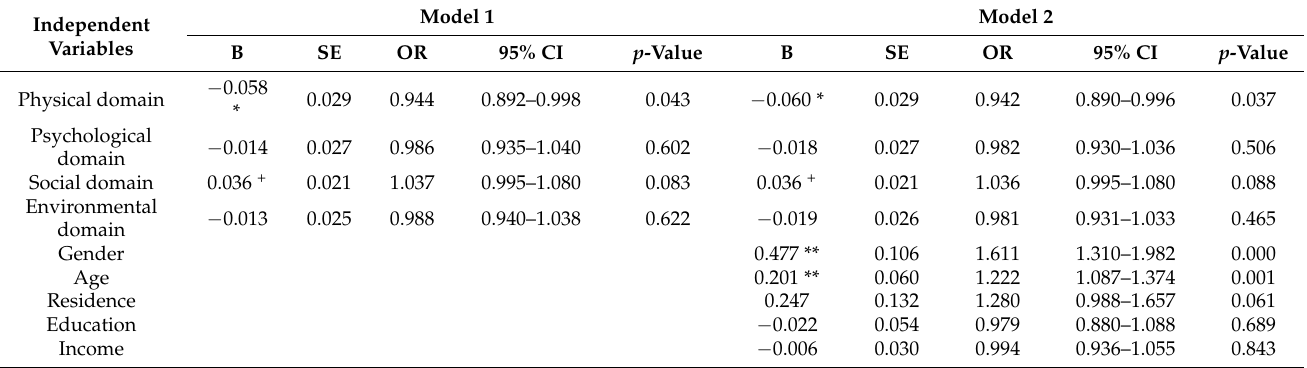
Table 3. Binary logistic regression analysis for predicting FFHR by WHOQOL-BREF